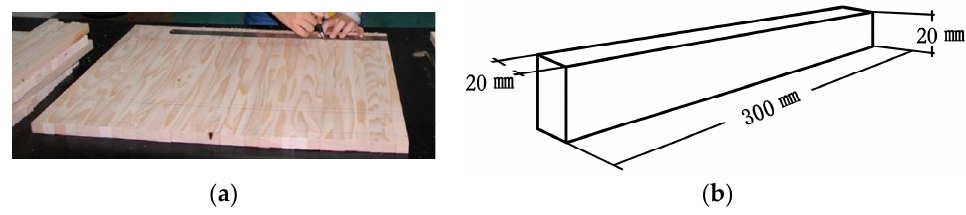
Figure 7. Small specimen: ( a ) Draw lines; ( b ) Small specimen size.